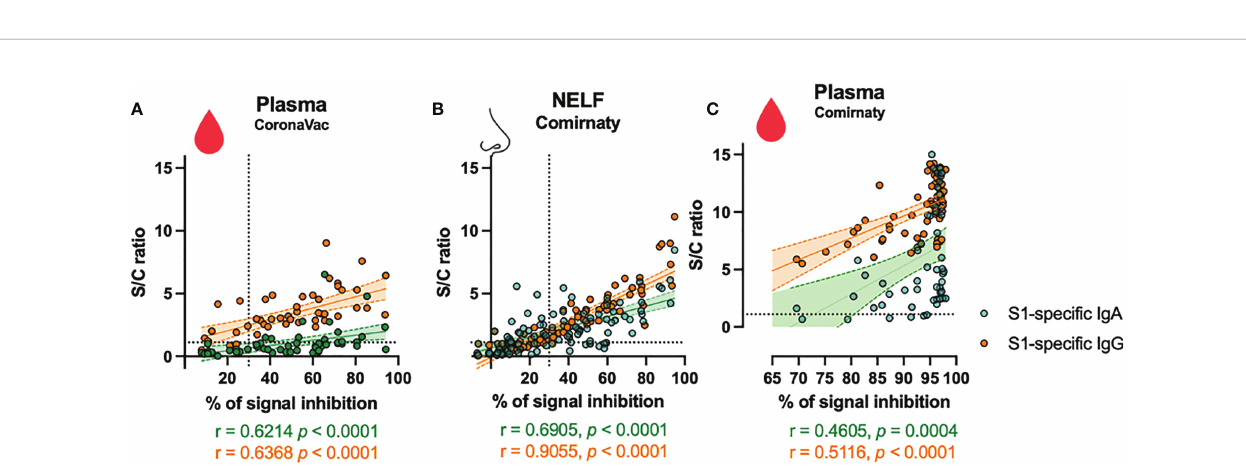
FIGURE 4 | Correlation of S1-speci fi c Igs to the percentage of signal inhibition in the surrogate ACE-2-based neutralization readout. The correlation coef fi cients of the levels of the (A) plasma of CoronaVac subjects, (B) nasal epithelial lining fl uid (NELF), and (C) plasma of Comirnaty subjects at 7 ± 2 days after the booster with the NAb are superimposed on the panel with the trend lines estimated with the use of simple linear regression. The plots show the S/C ratio of the SARS-CoV-2 S1-speci fi c IgA (green dots) and IgG (orange dots) <15 plotted against the percentage of inhibition of the SARS-CoV-2 spike-ACE-2 binding signal, in which inhibition ≥ 30% is regarded as the threshold of a positive sample, indicated by the vertical dotted line. Out-range speci fi c antibody levels were excluded from the two-tailed Spearman correlation analysis. The green and orange dotted lines represent signi fi cant linear regression fi ts with 95% con fi dence intervals (shaded region with the corresponding colors).